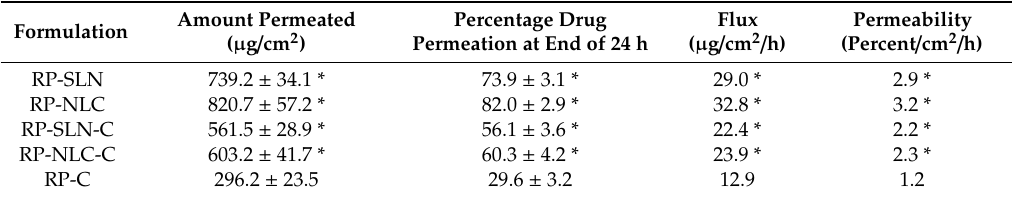
* indicates statistically significant at value of p < 0.05 compared with RP-C formulation.